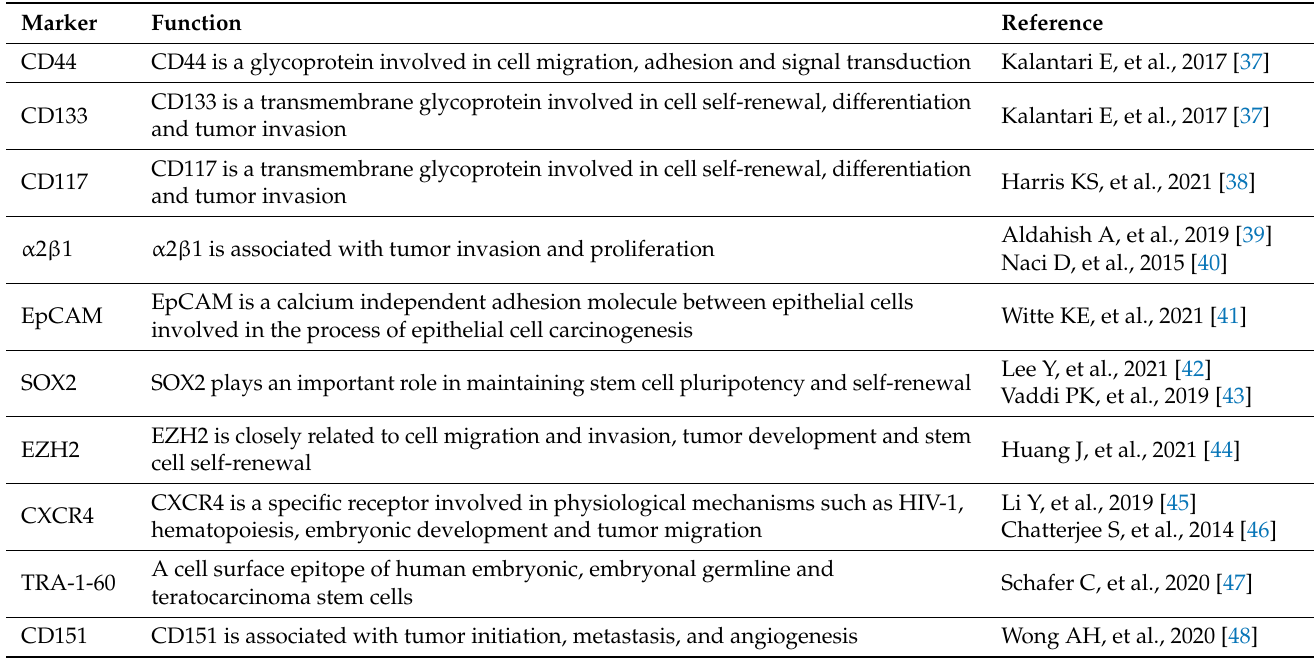
Table 1. Biomarkers for prostate cancer stem